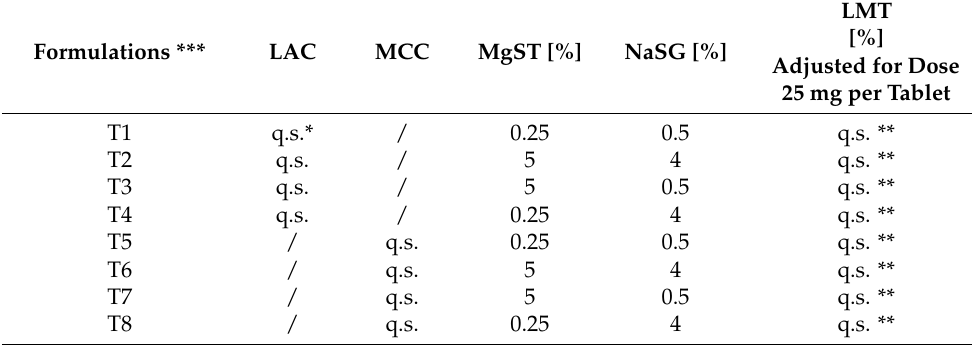
Table 1. Composition of immediate release LMT tablet formulations.